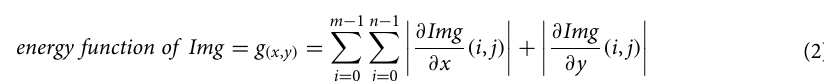
Figure 2. An illustration of the applied GAN model consisting of the ( a ) discriminator and ( b ) generator